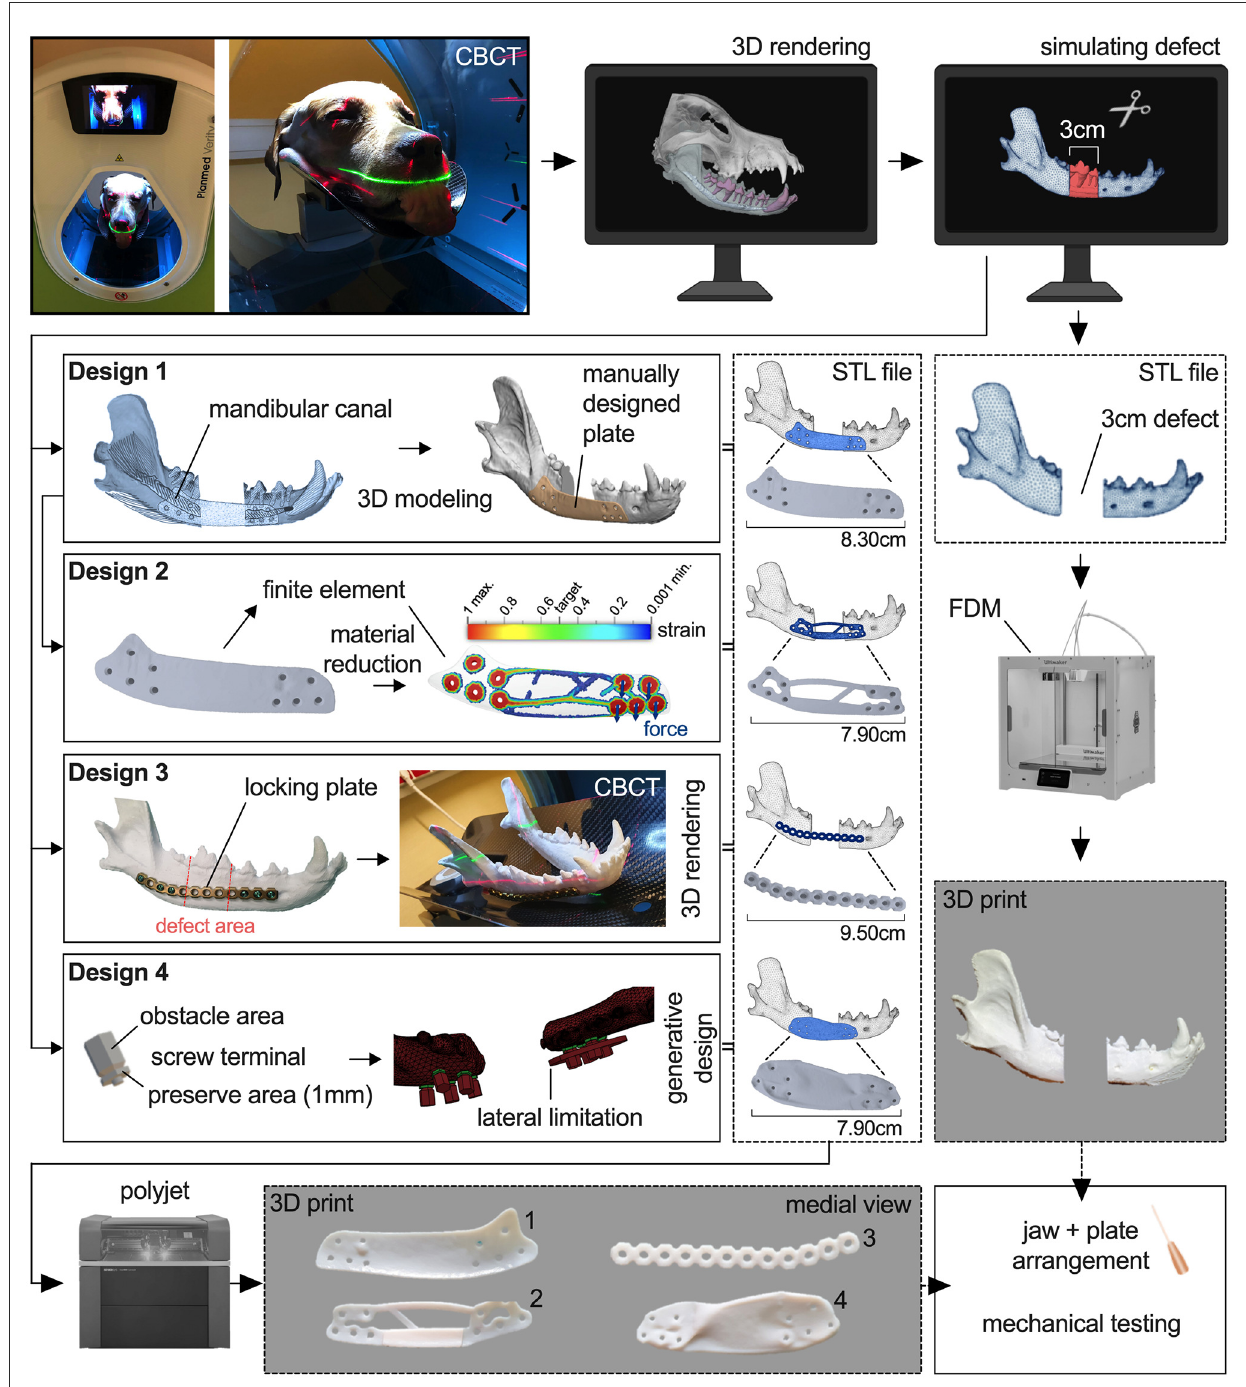
FIGURE1 Workflow showing the process of printing a 3D model of a right canine mandible with a simulated 30mm defect and the development and printing of four different plate designs.